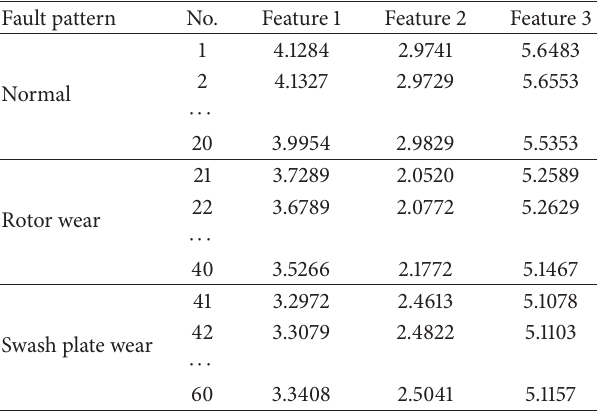
Table 2: Feature vector set after dimension